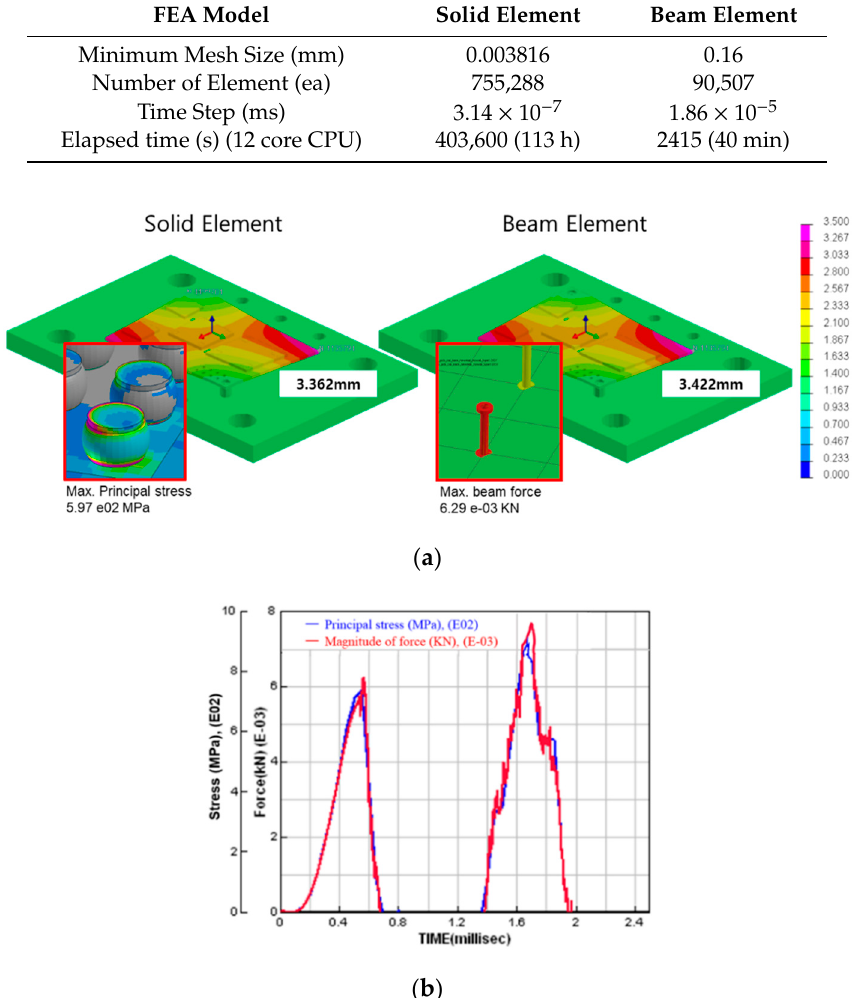
Figure 16. Solid model and beam model for the solder joint. ( a ) Displacement contour plots at 0.55 ms; ( b ) Principal stress (solid model) and force (beam model).